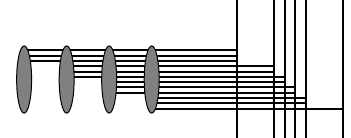
Figure 5. Brane configuration for a balanced quiver. It involves one group of 4 NS5-branes with 3 D3-branes ending on each, and three groups of D5-branes: a group of one D5-brane on which 3 D3-branes end, one group of 4 D5-branes with 2 D3-branes ending on each, and a group of one D5-brane with one D3-brane ending on it. This corresponds to ρ = [3 4 ] , σ = [3 1 , 2 4 , 1 1 ]